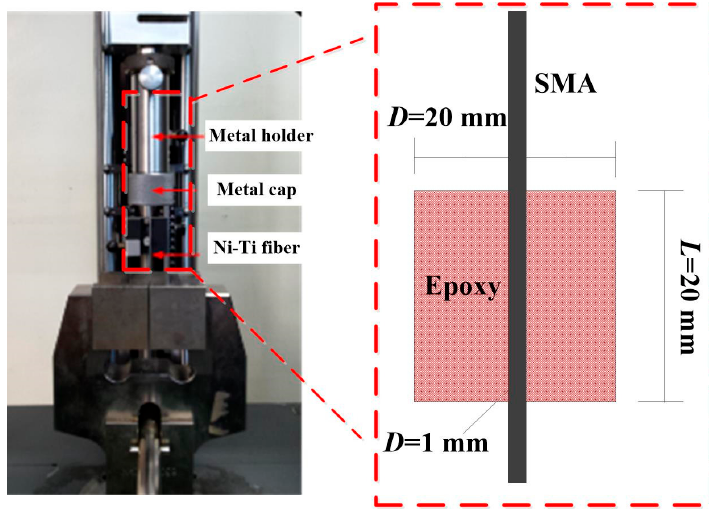
Figure 4. SMA fiber pull-out experiment setup.